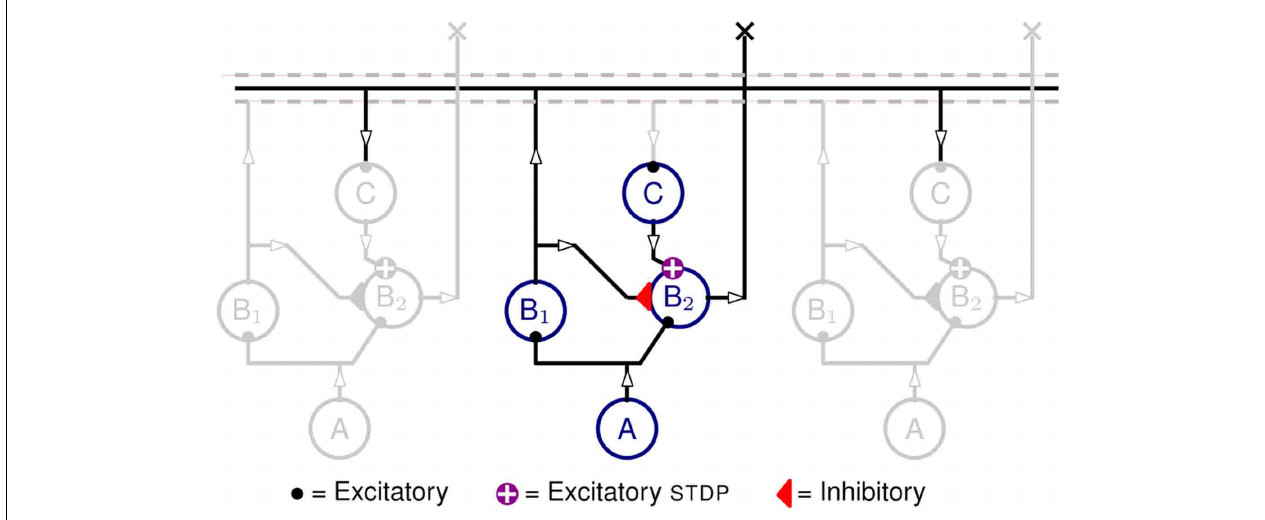
produced by A are projected onto both populations B 1 and B 2 . Neurons in B 2 also receive inhibitory inputs from B 1 neurons, as well as recurrent excitation from B 1 neurons of neighboring units via delay neurons C, and STDP synapses.The output of the network is represented by the activity of population B 2